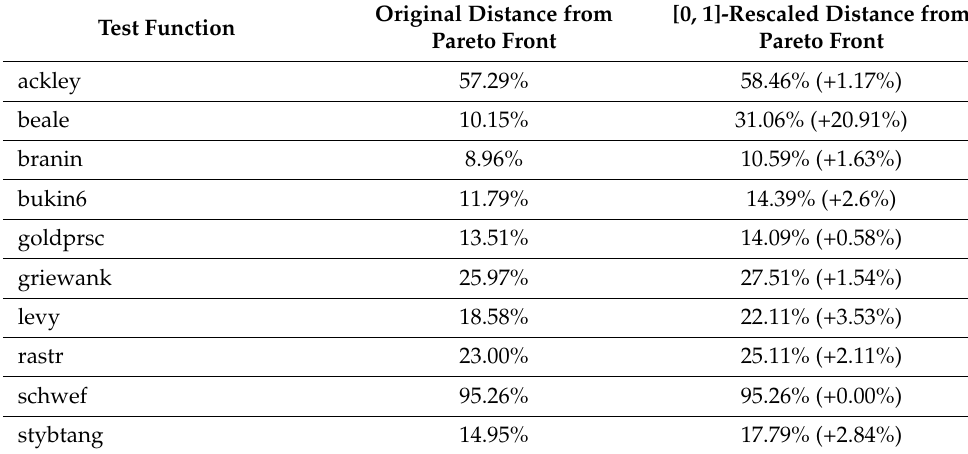
Table 1. Percentage of decisions labeled as Pareto (depending on a threshold 10 − 4 ) , separately for original and [0, 1]-rescaled distance from Pareto